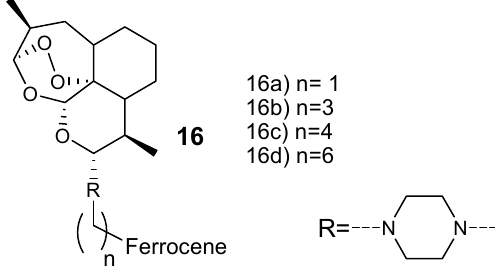
Figure 4. Artemisinin–ferrocene hybrid compounds ( 16 ).